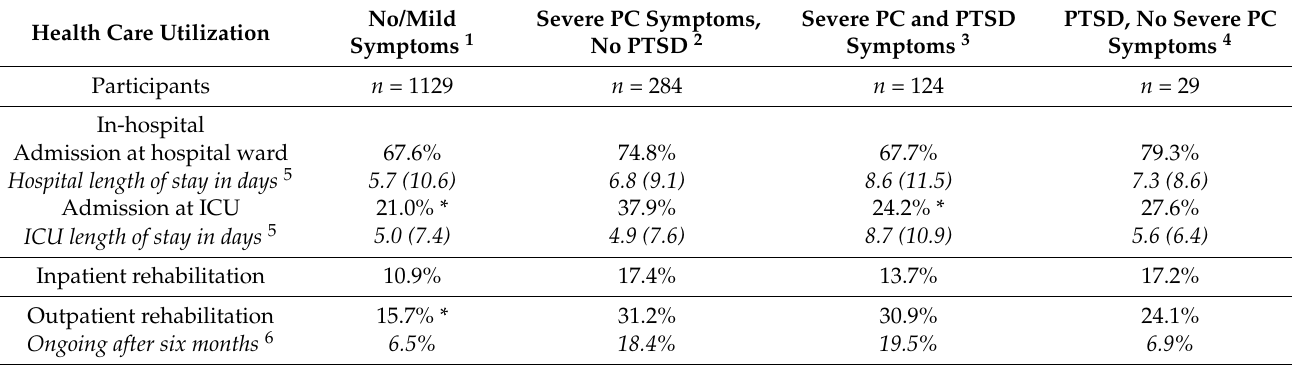
Table 3. Health care utilization by PC and PTSD symptom